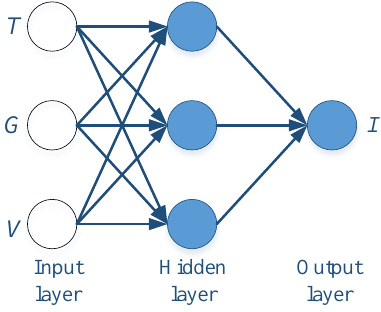
Figure 3. The architecture of neural network model of the